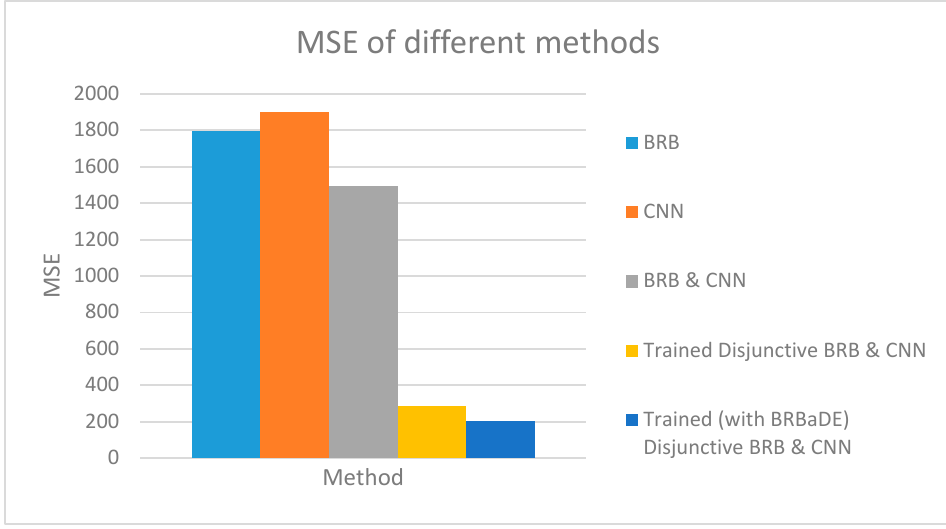
Figure 10. Testing dataset MSE of BRB, CNN, and our proposed integrated approach (BRB and CNN).